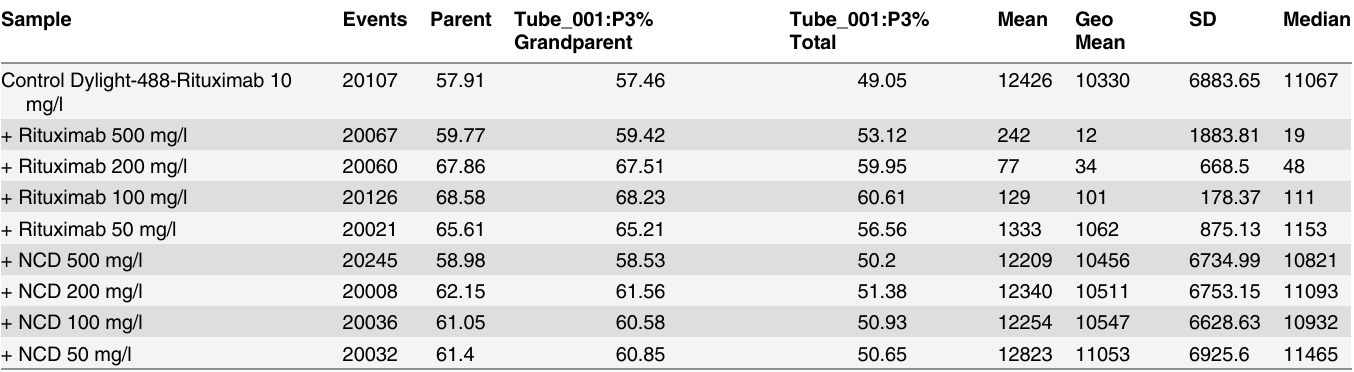
Table 1. Sample Events Parent Tube_001:P3%